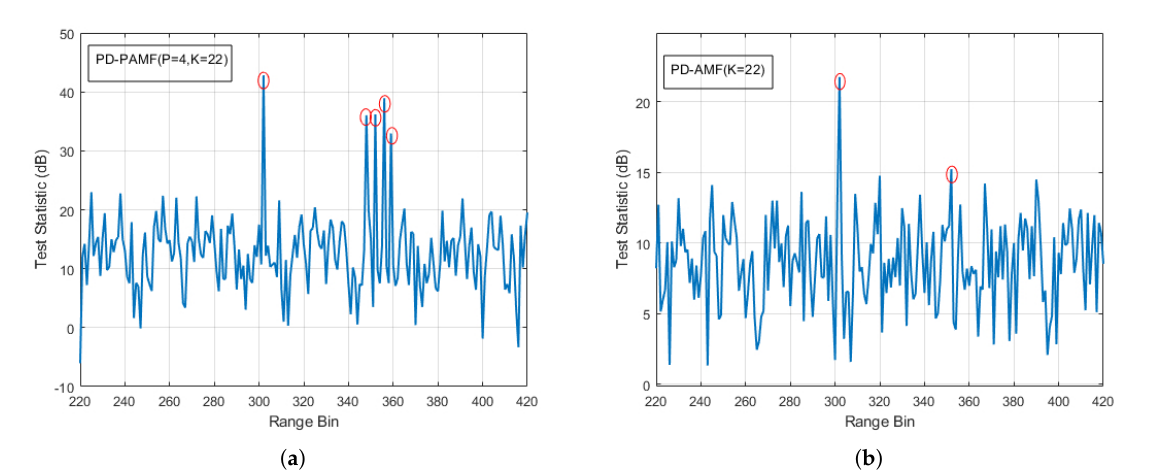
Figure 10. Detection results with K = 2N = 22 and moving windows and a target signal (red circle): ( a ) PD-PAMF test statistics, AR(4), five targets in R = 302, 348, 352, 356, and 359 and ( b ) PD-AMF test statistics, two targets in R = 302 and